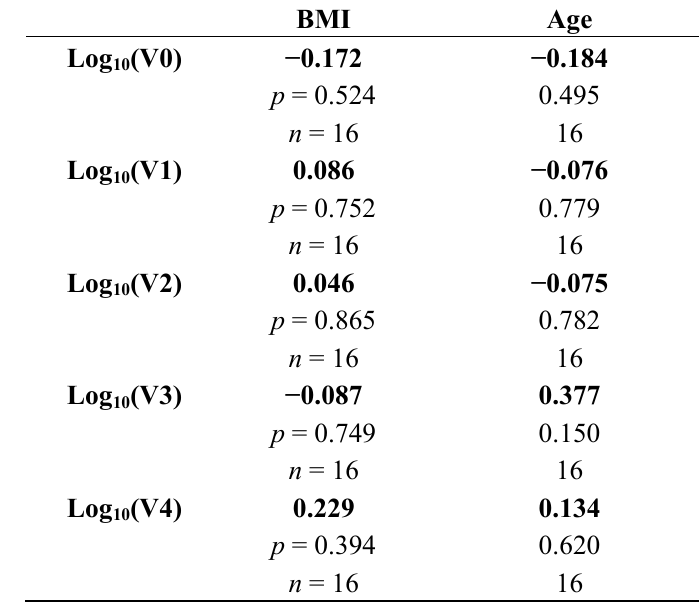
Table 4. Correlation of HE4 variants expression levels with endometrial cancer (EC) patients’ clinical data. The Pearson correlation coefficient analysis is performed between HE4 variant levels and patients’ age, BMI, and survival time. No significant correlation between HE4 variant levels and clinical data was found in normal endometrium group (Table